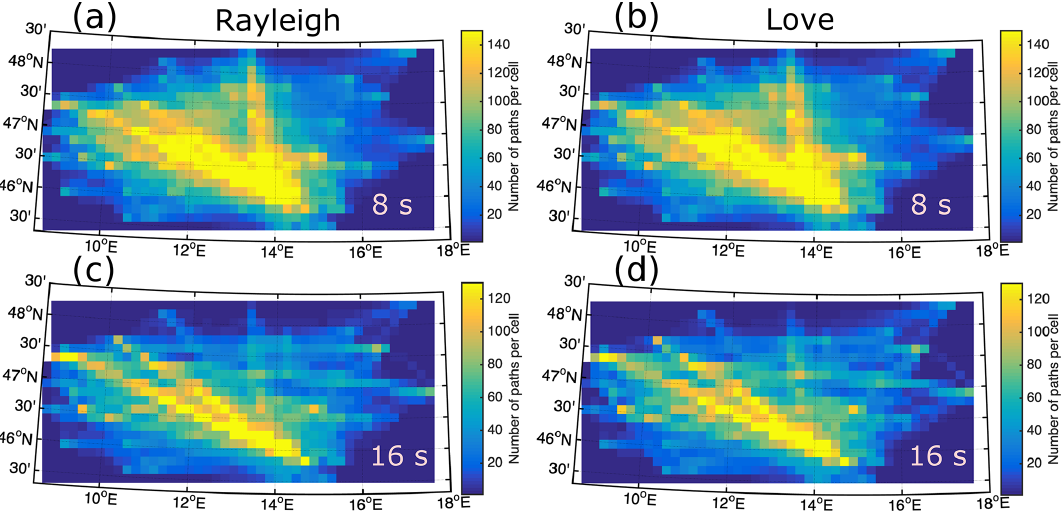
Figure 6. Path density map for the tomography inversion: (a, c) for Rayleigh waves at 8 and 16s, respectively and (b, c) for Love waves at 8 and 16s. The path coverage is generally good for the entire region. Most of the cells have a path density more of than 20 rays per cell. Path density maps at larger periods are also shown in Supplement Fig.